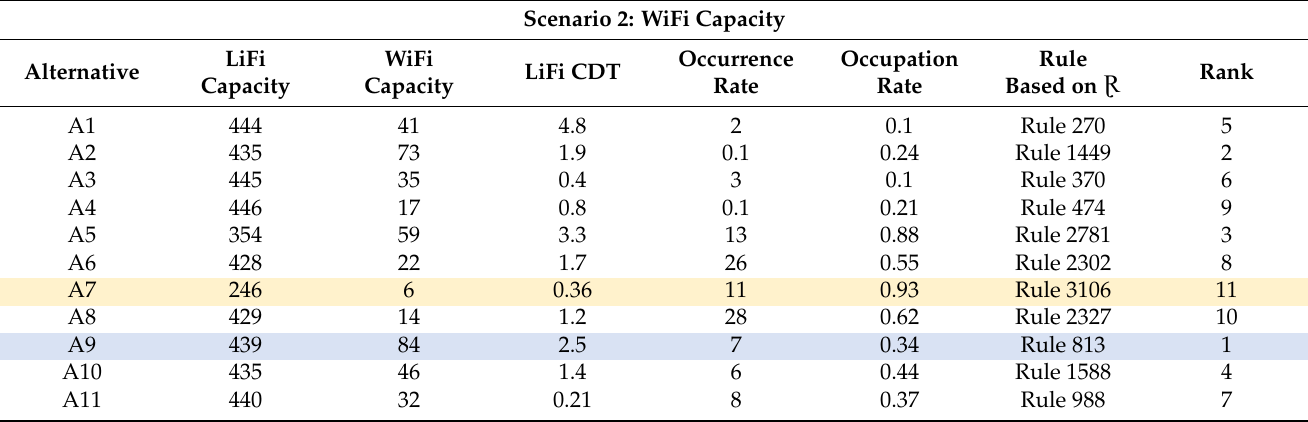
Table 10. Using Criteria #2 (WiFi capacity) for ranking the best and worst alternatives.